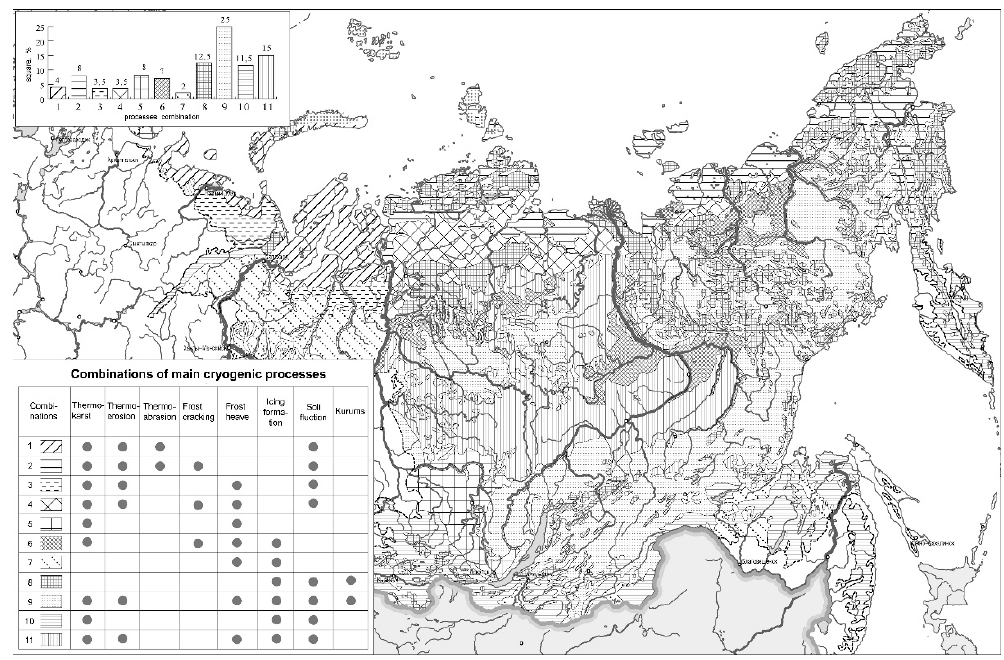
Figure 13. The map of combinations of the main cryogenic processes.